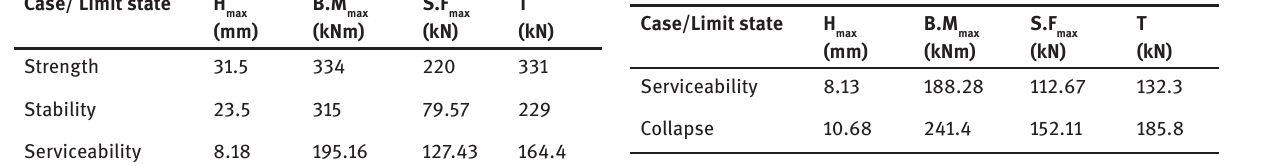
Table 6: Results of analysis using Australian codes.